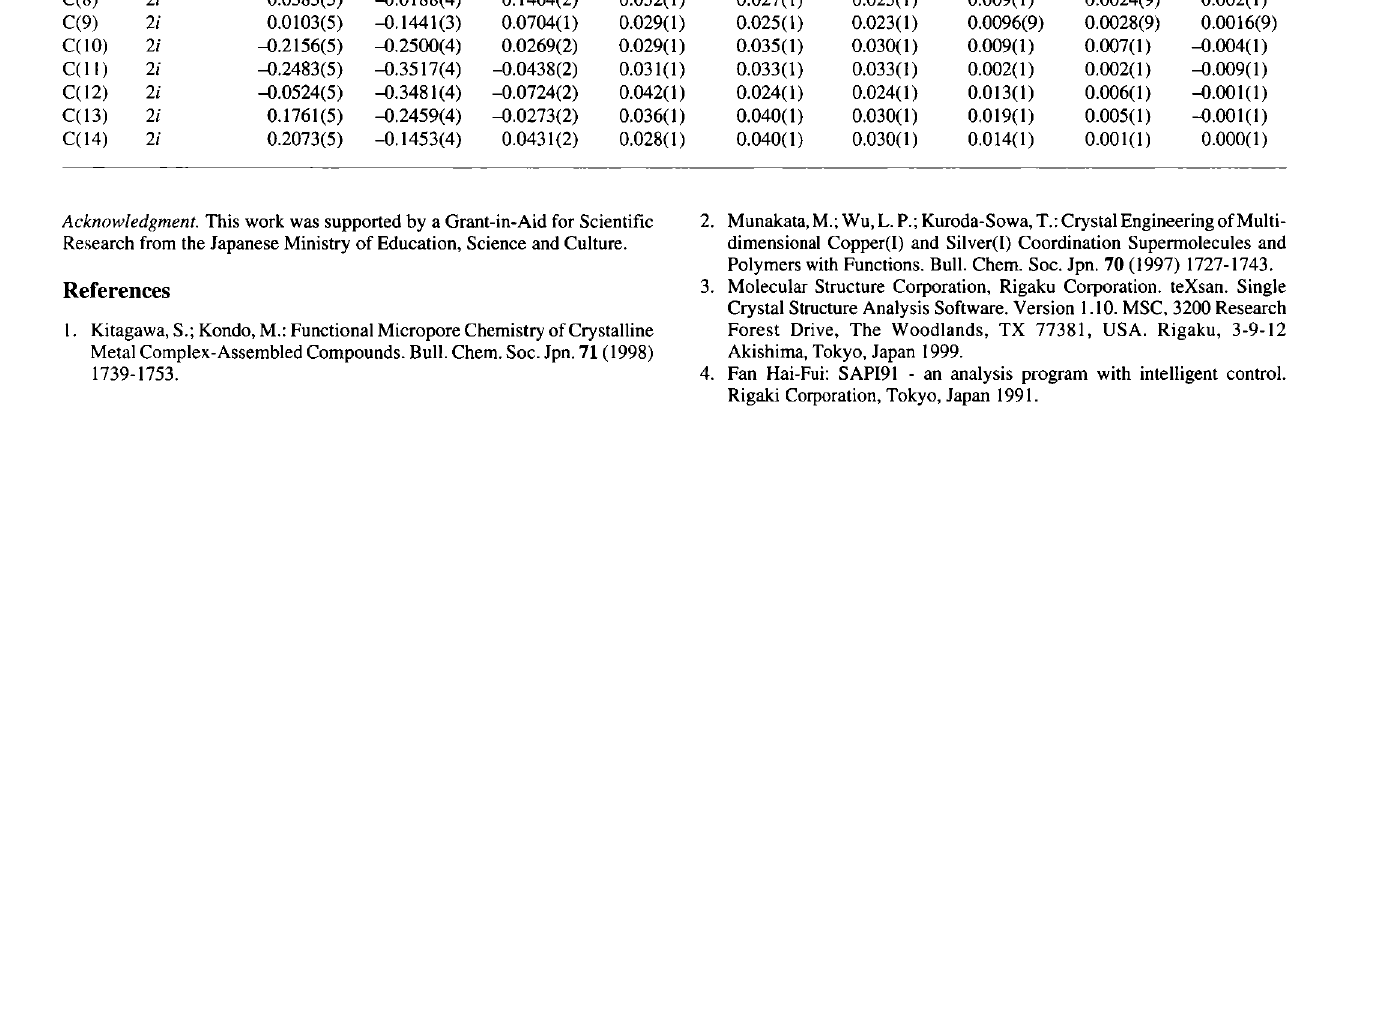
Table 3. Atomic coordinates and displacement parameters (in Ä 2 ).